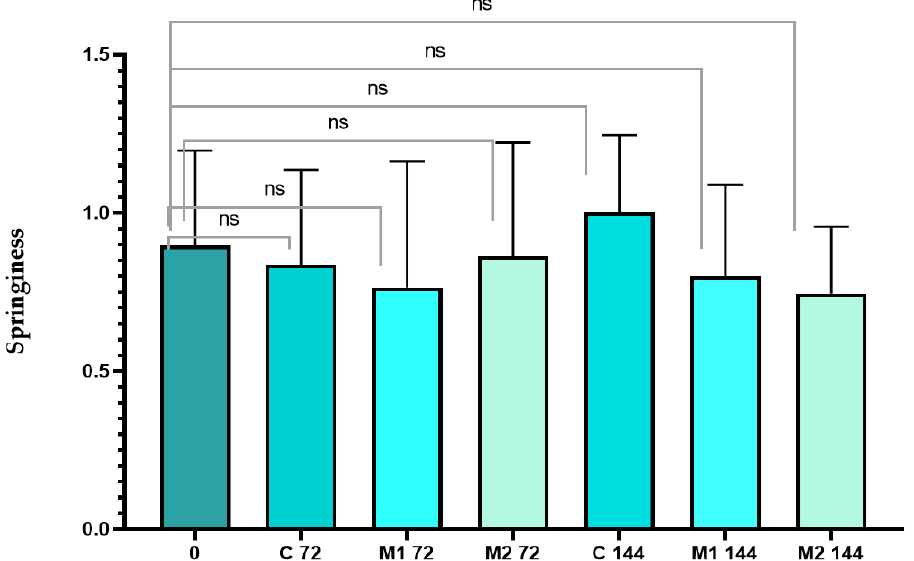
Figure 6. The springiness of the sliced chicken sausage. ANOVA: ns—not significant.